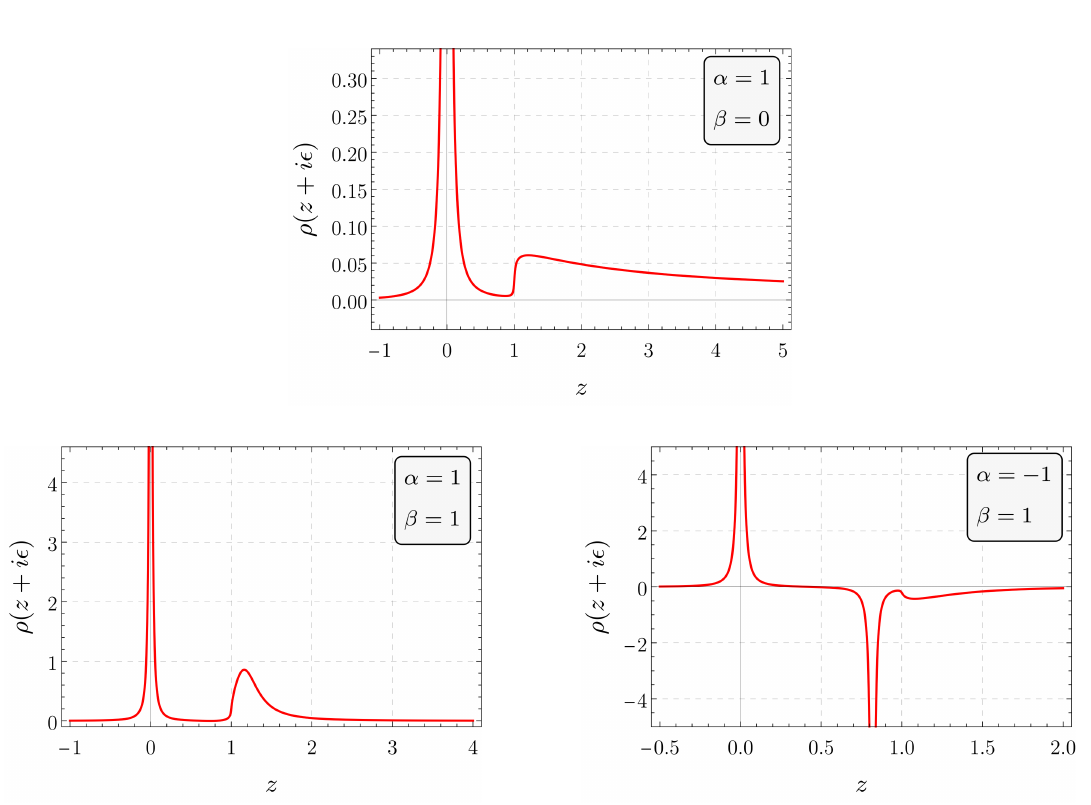
Figure 2 . Spectral densities for the models summarized in table 1, for (cid:15) = 0 . 01 . In the case of QED (top panel), the spectral density is positive-definite, within the regime of validity of the theory. At the level of the spectral density, the branch cut in the propagator generates a continuum part, corresponding to a multi-particle state. In the case of Lee-Wick QED (bottom-left panel), the branch cut is associated with a ghost resonance, characterized by a negative width. This makes the spectral density positive-definite. If α < 0 (bottom-right panel), the propagator in eq. (3.10) has a pole within its principal branch, corresponding to a stable ghost pole. In this case the spectral density can also be negative and unitarity is